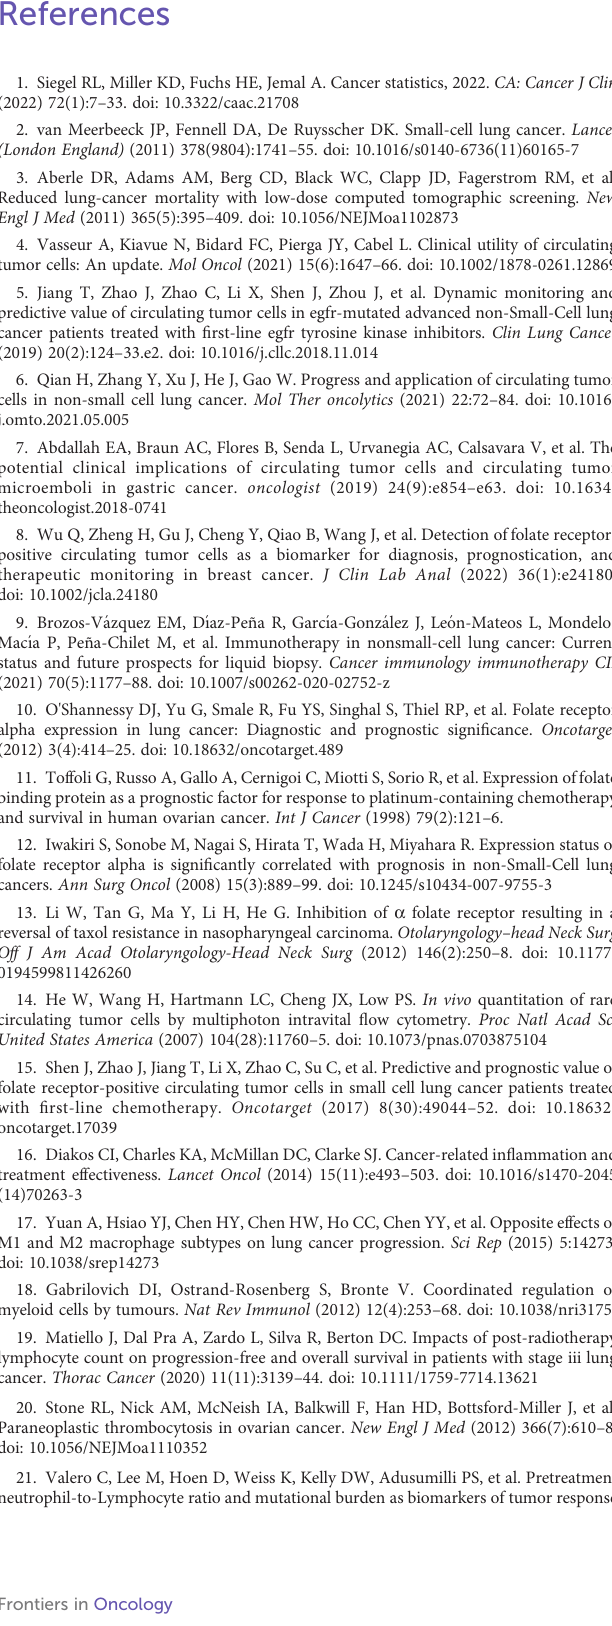
SUPPLEMENTARY FIGURE 1 Kaplan – Meier curves for survival probability according to the NLR between surgery and systemic therapy. SUPPLEMENTARY FIGURE 2 ROC curves of the NE count, PLT count, NLR and PLR in the diagnosis of lung cancer